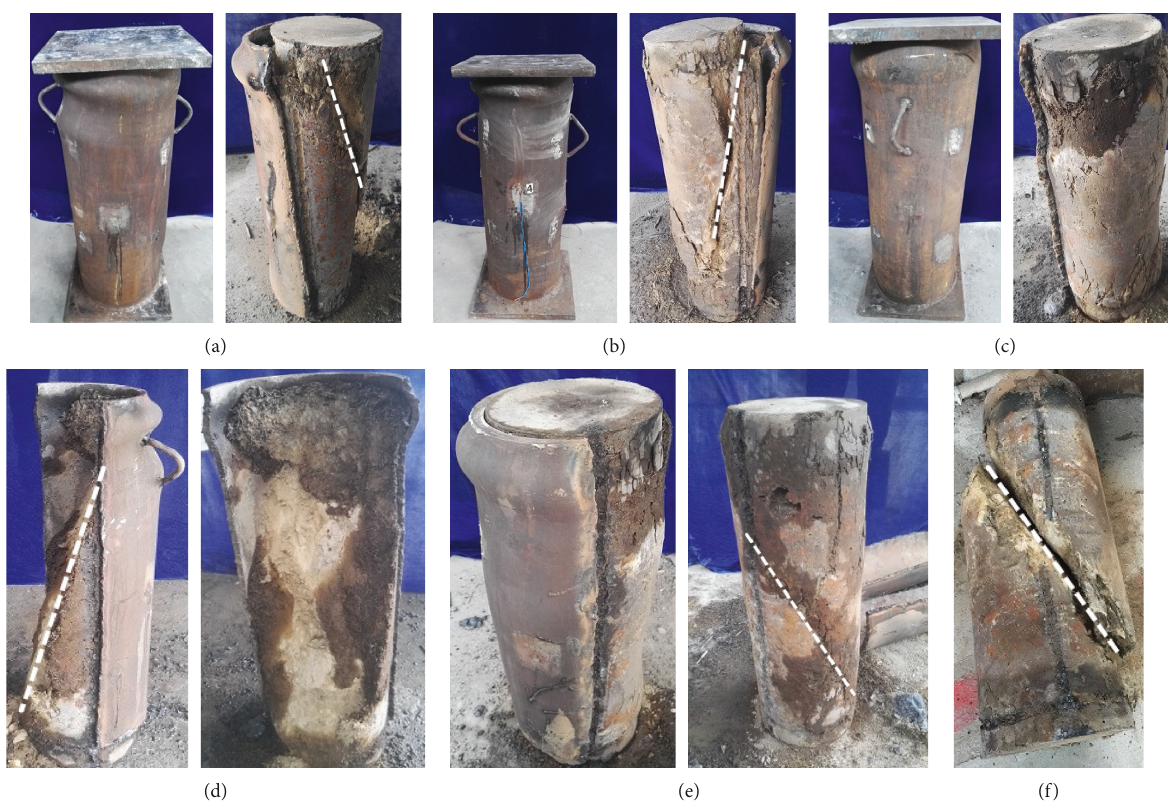
Figure 4: Failure modes of group-c specimens. (a) c-219-8 (shear failure). (b) c-219-10 (shear failure). (c) c-219-12 (compressive failure). (d) c-245-8 (shear failure). (e) c-245-12 (shear failure). (f) c-273-10 (compressive